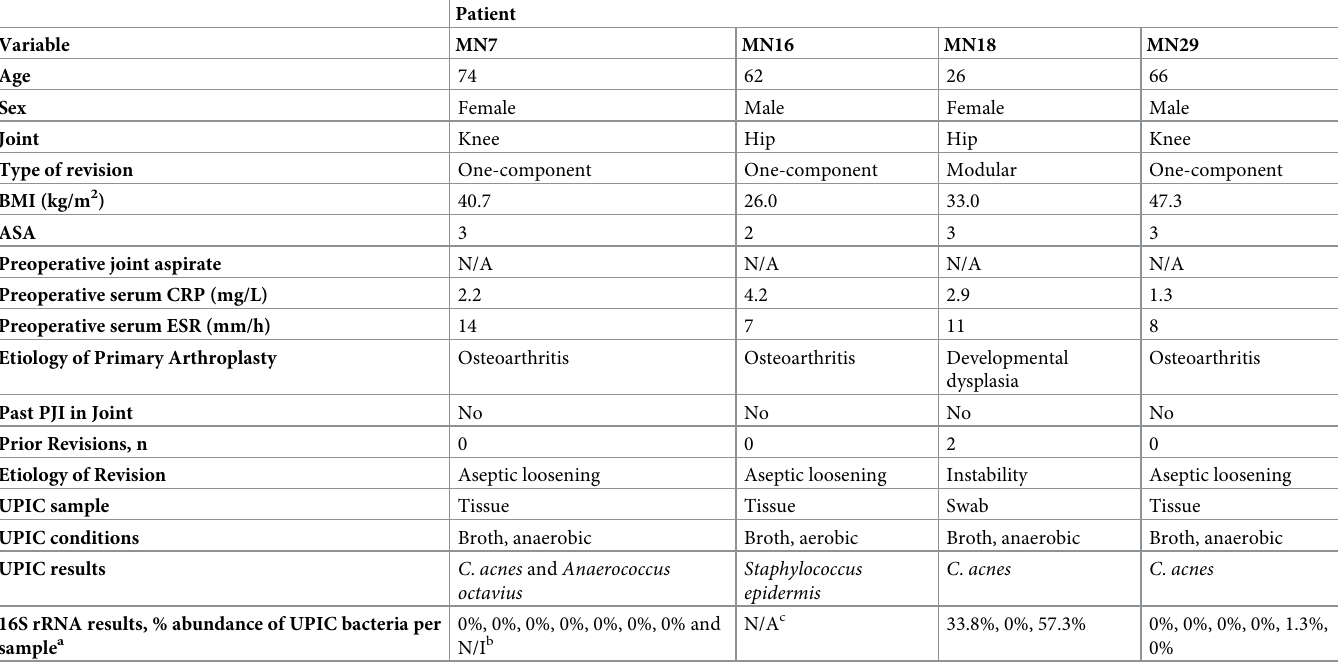
Table 2. Clinical, microbiological culture, and sequencing data for patients with unexpected positive intraoperative